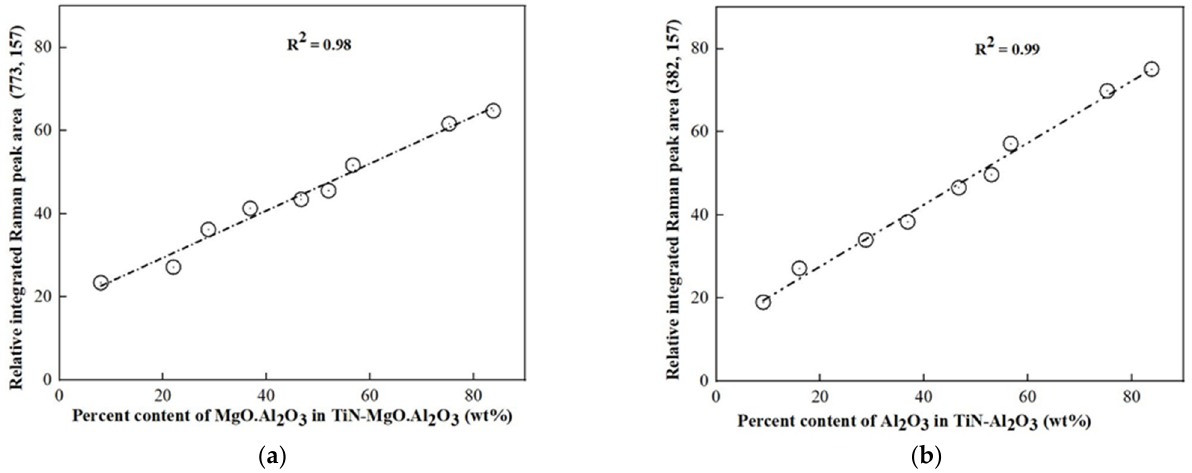
Figure 5. Estimation of phase contents based on relative integrated Raman peak area as a function of the phase content of MA in ( a ) Ti 2 O 3 –Al 2 O 3 and ( b ) TiN–Al 2 O 3 .